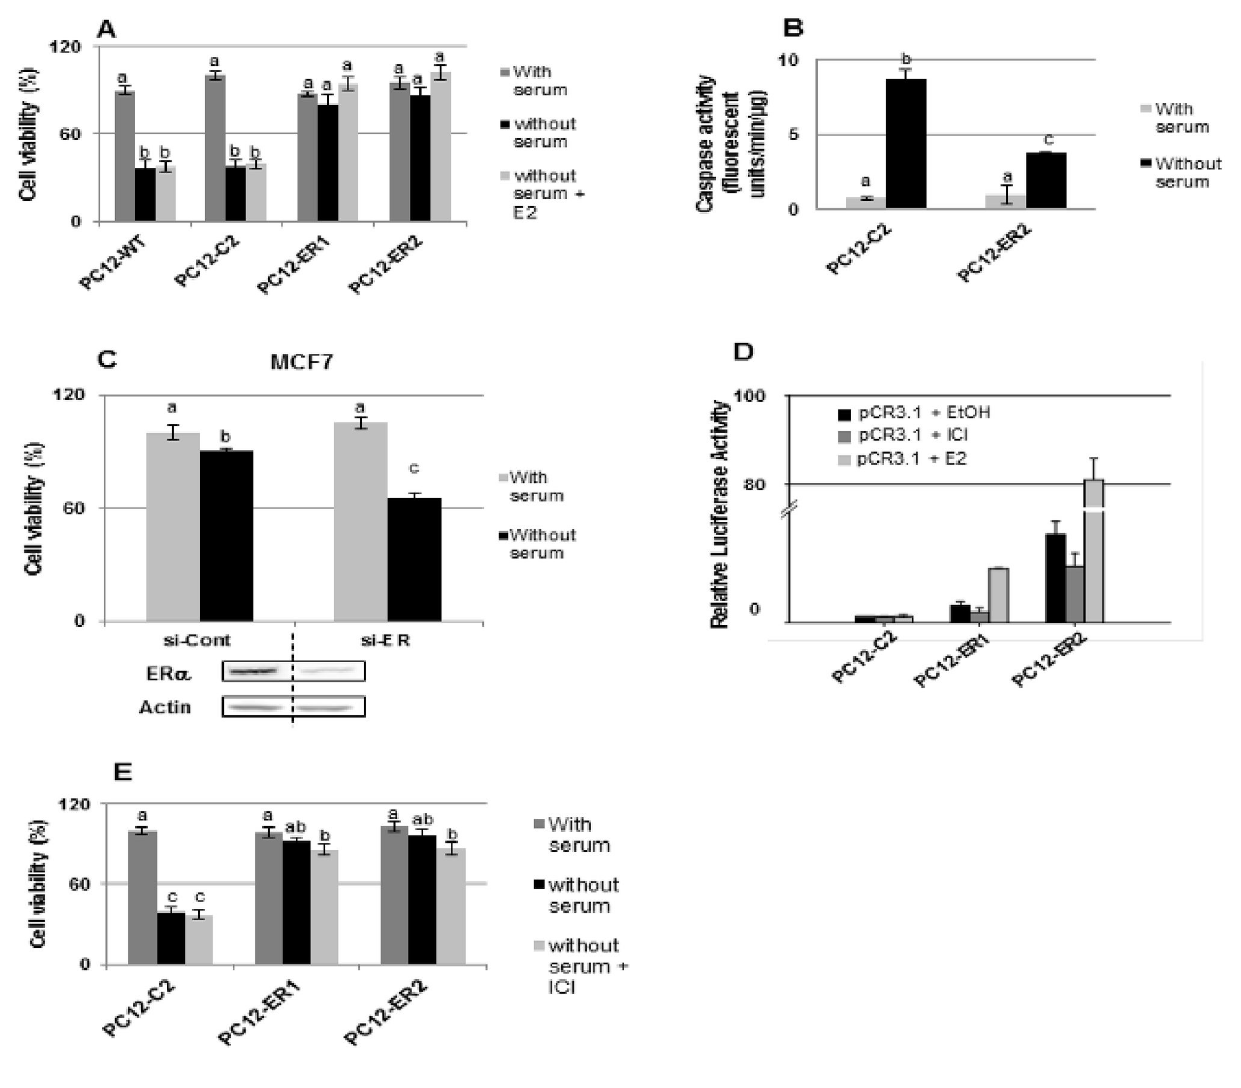
Figure 1. Unliganded ERα protects cells against apoptosis. A) - PC12 wild type cells (PC12-WT), PC12 cells transfected with the empty plasmid (PC12-C2) or PC12 stably transfected with ERα encoding plasmid (clones PC12-ER1 and PC12-ER2) were grown in the presence or not of charcoal stripped FCS for 24 hrs with or without E (10 -8 M). Cell viability was then assessed using 2 the quantification of cellular ATP (Vialight HS kit from Lonza). Results are expressed in reference with control clone (PC12-C2) maintained in 5% charcoal stripped FCS. B) - caspase-3 activity was determined in control clone (PC12-C2) and in ERα-positive cells (PC12-ER2) after 24 hrs of culture in the presence or not of charcoal stripped FCS. C) - MCF7 cells were transfected with siRNA targeting ERα or with non-specific siRNA. Twenty four hours later, MCF7 cells were maintained in phenol red-free DMEM/F12 medium containing or not 10% charcoal stripped FCS for 24 hrs before cell viability was assessed using ViaLight HS kit (Lonza). In order to control knockdown efficiency, total protein was extracted from MCF7 cells and the level of ERα was analyzed by western blotting. D) - PC12-C2, PC12-ER1 and PC12-ER2 cells were transiently transfected with an ERE-TK-Luc reporter gene together with CMV-β-Gal. Twelve hours after transfection, the cells were treated or not with E (10 -9 M) or ICI (10 -7 M) for 24 hrs. 2 Normalized luciferase activities were standardized to the reporter gene activity measured in ethanol treated PC12-C2 cells. E) - PC12-C2, PC12-ER1 and PC12-ER2 cells were grown in medium with or without FCS for 24 hrs, in the presence or not of ICI (10 -7 M). Cell viability was then assessed using ViaLight HS kit (Lonza). Results are expressed in reference with control clone (PC12-C2 maintained in 5% charcoal stripped FCS. For all the experiments, values correspond to the mean ± SEM of at least three separate experiments. Columns with different superscripts differ significantly (p<0.05 by Student test).